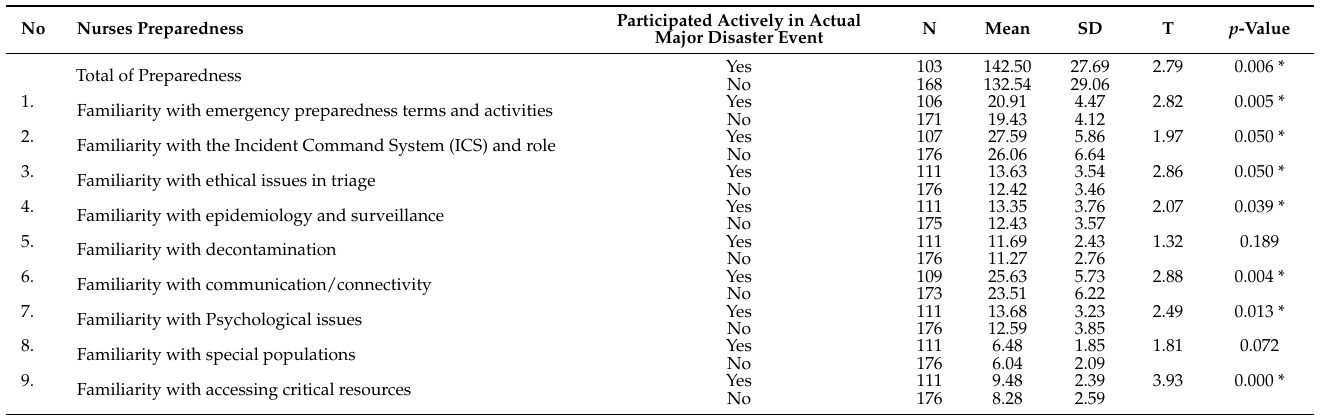
Table 2. The t -test of nurses’ preparedness and its sub-dimensions in managing the COVID-19 pandemic based on their participation in an actual major disaster